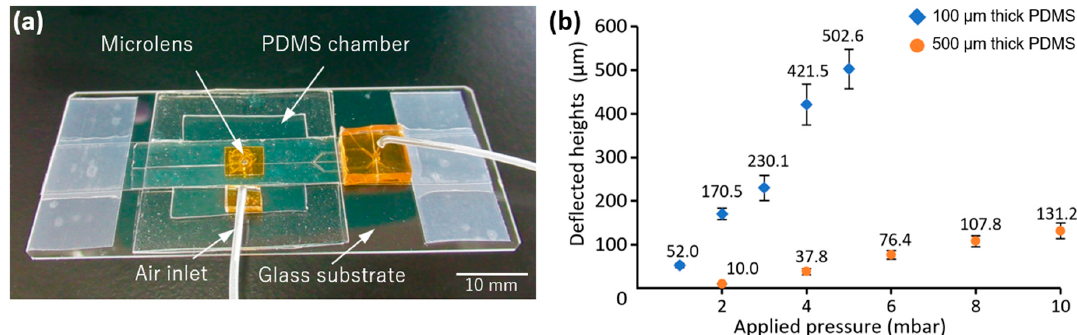
Figure 6. Device for the PDMS layer inflation measurement and the obtained results. ( a ) Photo of the fabricated device. ( b ) Graph results of the two different thicknesses of the PDMS layers inflations, measured as deflected heights at various air pressures.